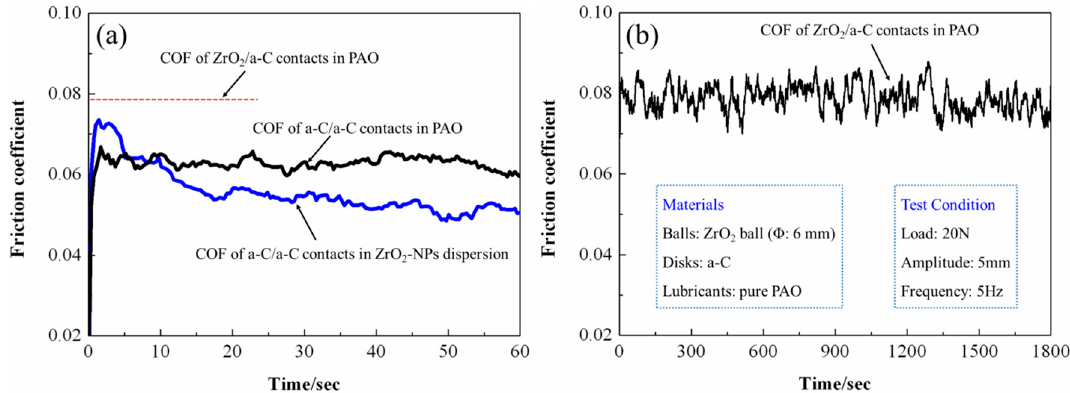
Figure 13. ( a ) The COF variation of a-C contacts during the initial stage under the lubrication of pure PAO and ZrO 2 -NPs dispersion; ( b ) The COF variation of ZrO 2 /a-C contacts under the lubrication of pure PAO, the inset presents the test conditions.